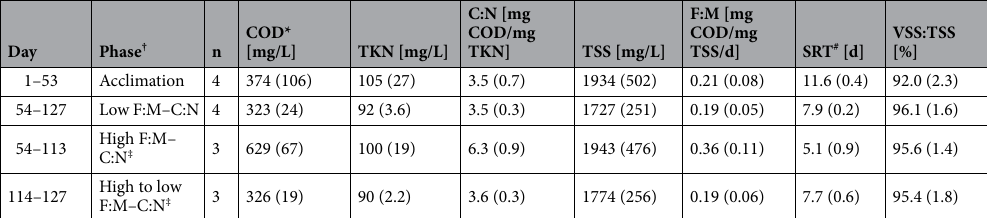
Table 1. Influent synthetic wastewater characteristics and reactor operational parameters per phase. *Average values, including standard deviation of the mean (s.d.m.) in parentheses. † Each phase featured independent 5-L reactors. Samples were generated 2–3 times per week. ‡ These two phases involved the same three reactors, where the F:M–C:N was changed from high to low on d114. # Aerobic SRT, based on the aeration period (61.8%) of each cycle.